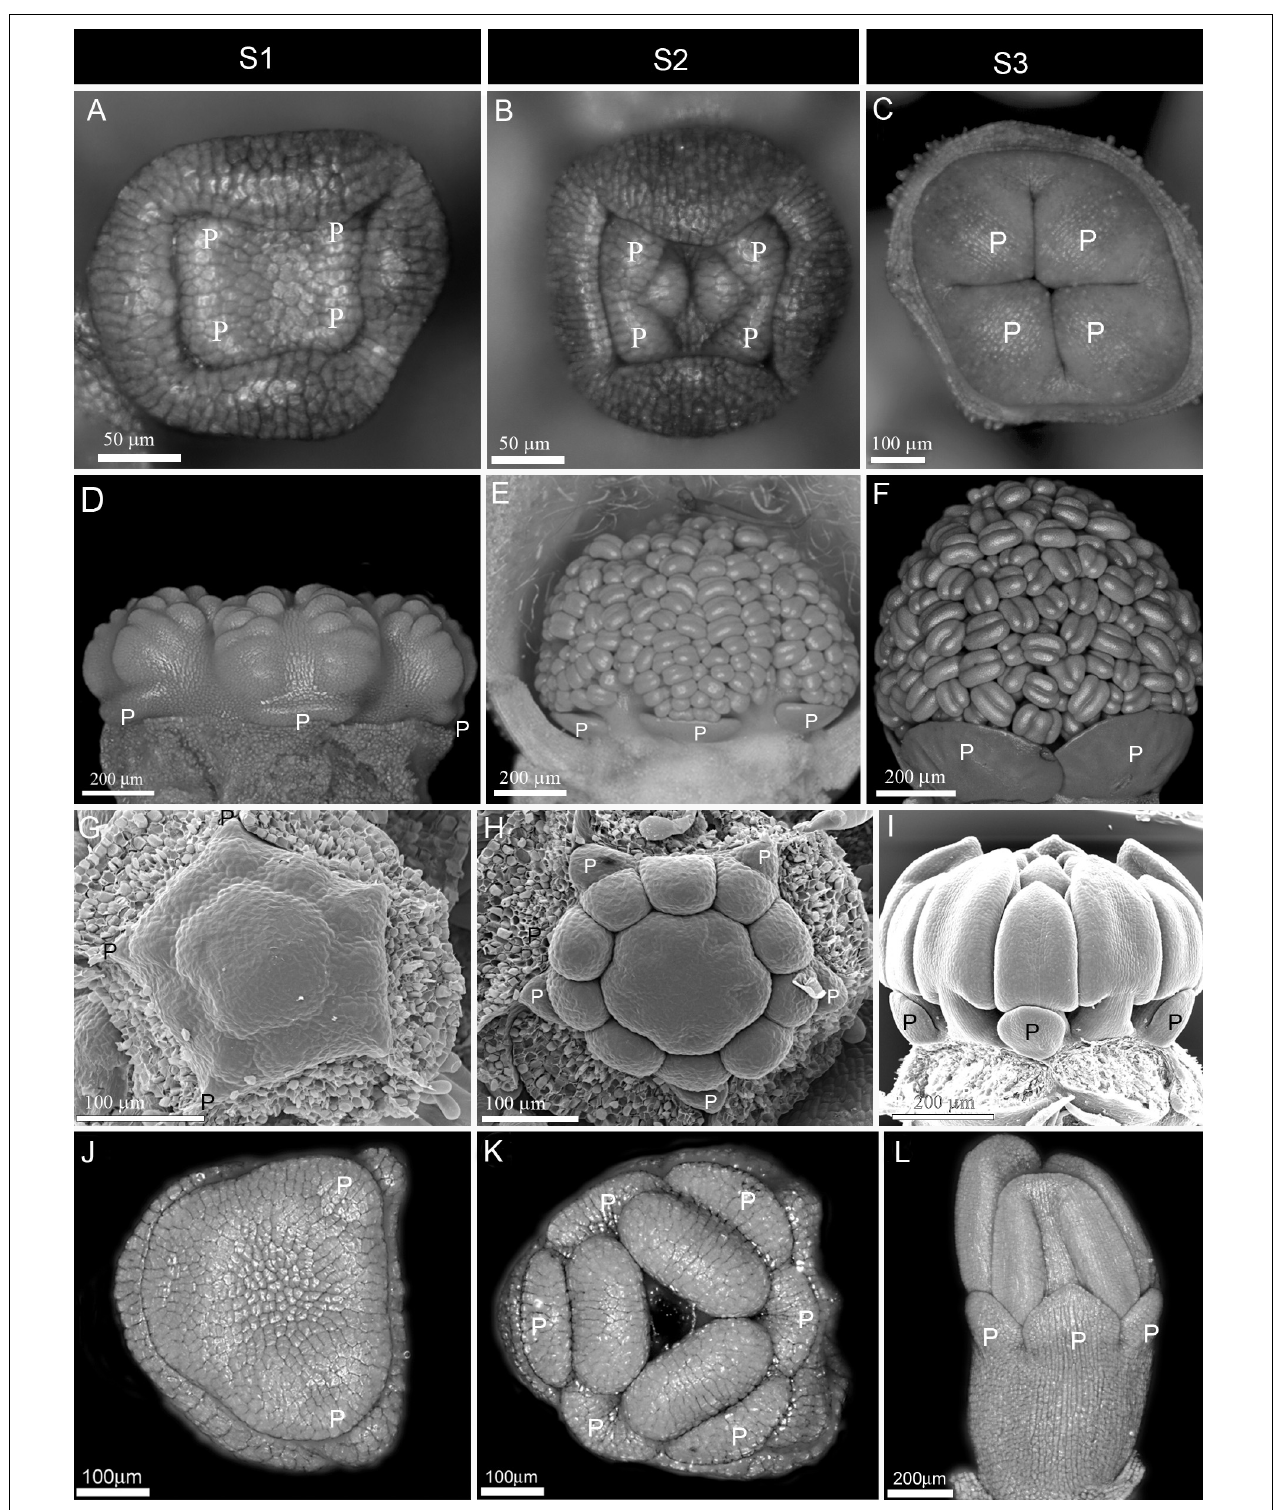
FIGURE 1 | Early to mid-stage establishment of actinomorphy in corolla. (A–F) Simultaneous initiation followed by synchronous enlargement and differentiation in Syringa vulgaris from Oleaceae (A–C) and Alcea rosea from Malvaceae (D–F) . (G–I) Non-simultaneous initiation followed by synchronous enlargement and differentiation in Zygophyllum fabago (Zygophyllaceae). (J–L) Non-simultaneous initiation of petals within each whorl followed by synchronous enlargement and differentiation in Crocus sativus (Iridaceae). P: petal, S1: Initiation phase, S2: Enlargement phase, S3: Differentiation phase.